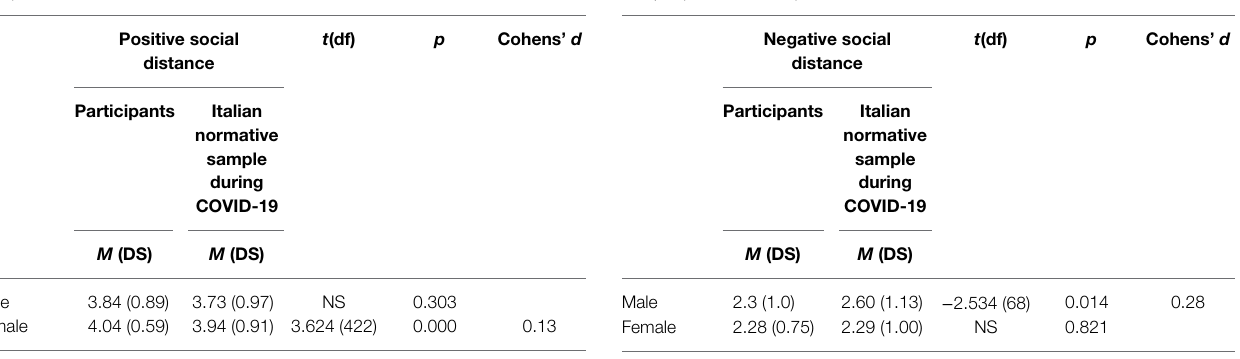
TABLE 7 | Positive attitudes toward comparison between the average values of the participants and the average values of the Italian normative sample (An et al., 2021).